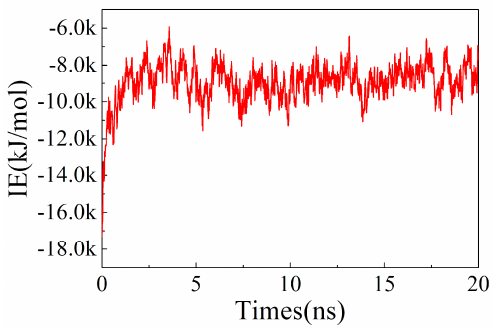
Figure 7. The interaction energy (IE) vs. times.